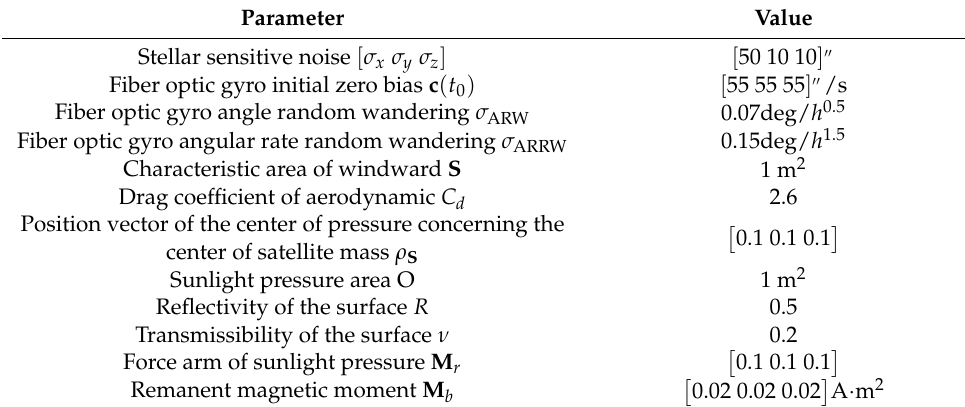
Table 8. Disturbance simulation